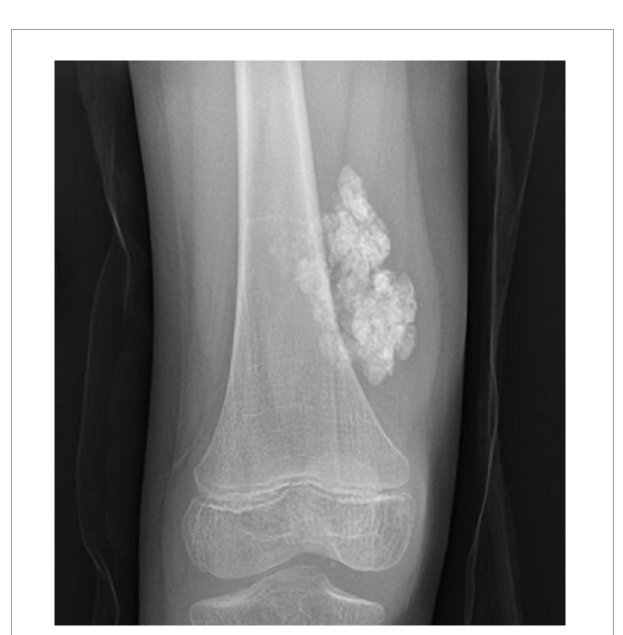
FIGURE2 Plain radiograph of calcinosis lesions in the subcutaneous tissues adjacent to the right knee of a child with juvenile dermatomyositis. Permission obtained from the patient for publication of this